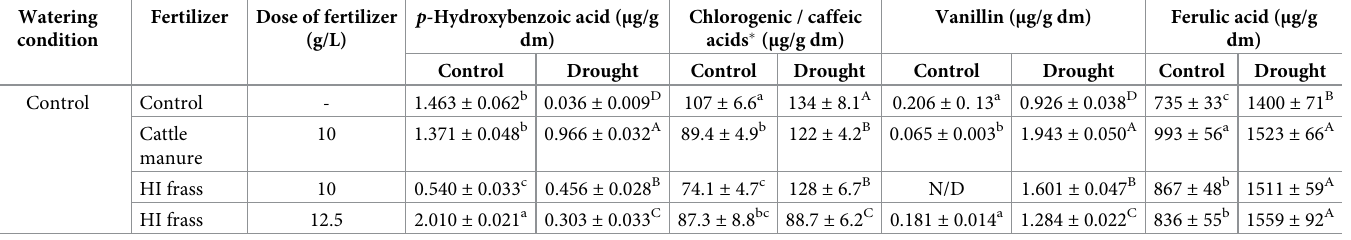
Table 6. Phenolic compounds determined by HPLC in basil methanolic extracts, from plants cultivated under various water regimes and with various fertilizer formulations. Watering